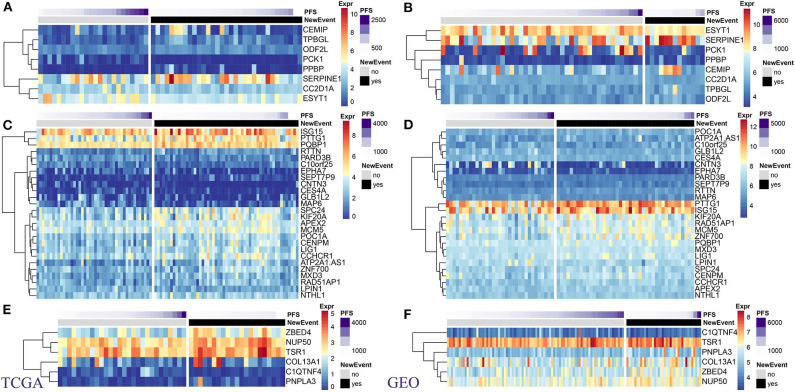
Expression levels of prognostic MRS in pathological subtypes of sarcomas. TCGA: (A) DL. (C) LMS. (E) UPS. GEO: (B) DL. (D) LMS. (F) UPS. (Left panel: TCGA dataset. right panel: GSE41258 data set).